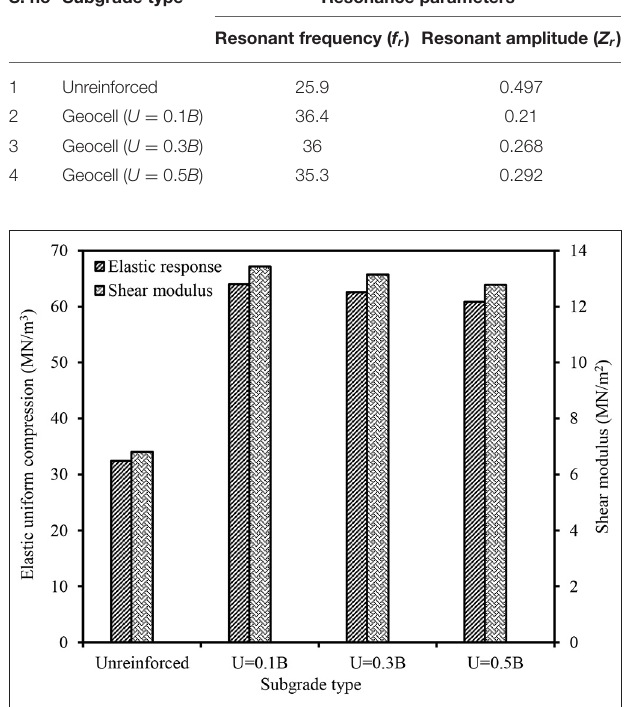
FIGURE 6 | Variation of dynamic parameters with the change in depth of placement of